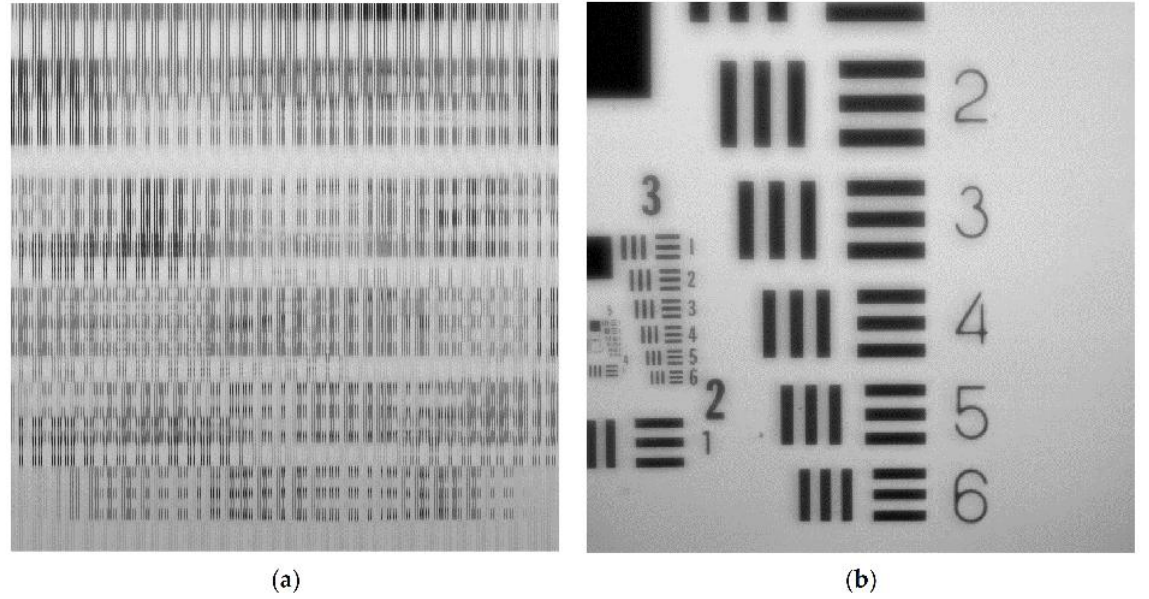
Figure 18. 2048 × 2048 image using TuMag camera. ( a ) Unordered image; ( b ) ordered